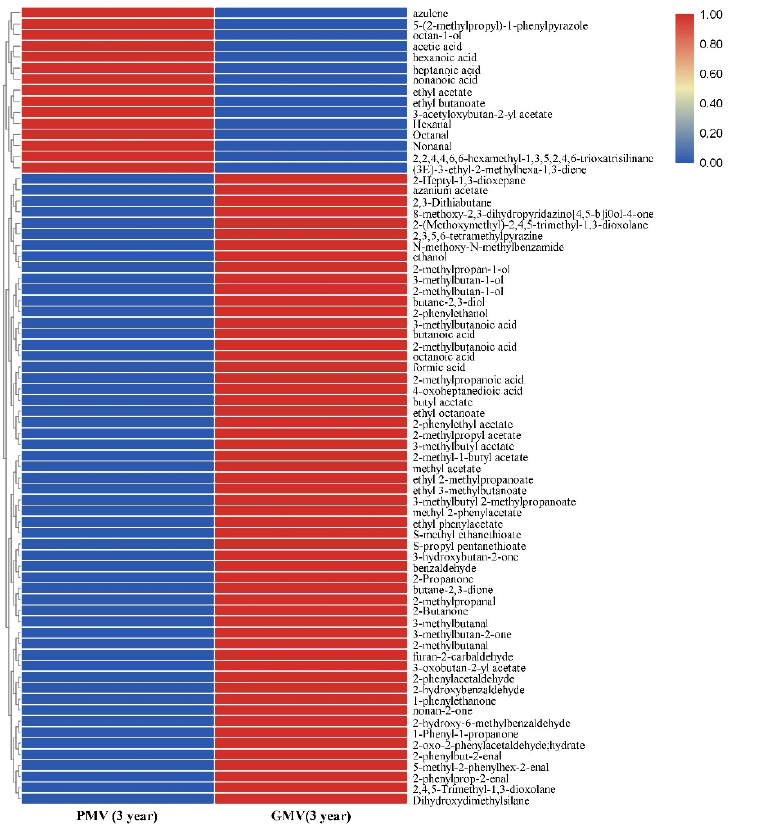
Figure 6. Heatmap of volatile compounds of two three-year aging MVs. Abbreviations: PMV- Monascus vinegar using polished rice as raw material, GMV- Monascus vinegar using sprouted rice in the husk as raw material.